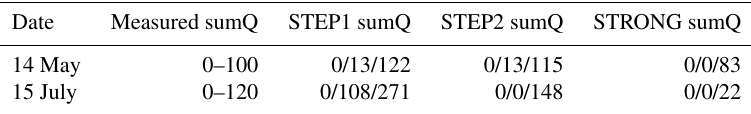
Table 6. Runoff volume (mL) from real rainfall events, measured versus simulated with the skinfactors predicted by the new transfer functions.